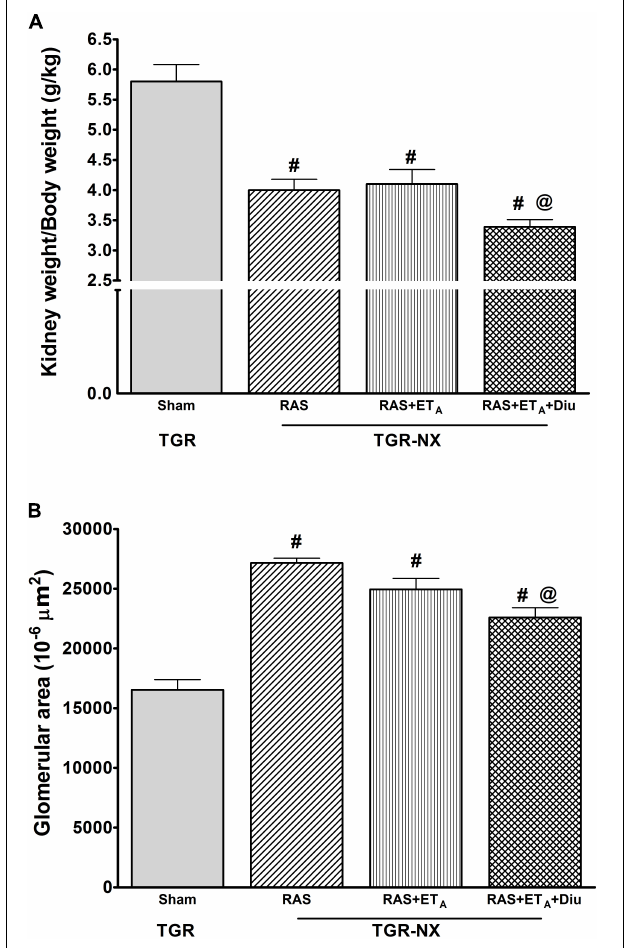
FIGURE 5 | The effect of diuretic treatment added to combined RAS and ET A blockade on histological markers of renal damage. Glomerulosclerosis index (A) and kidney tubulointerstitial injury (B) in sham-operated heterozygous Ren-2 transgenic rats (TGR-sham), nephrectomized TGR (TGR-NX) treated with the renin-angiotensin system blockade alone (RAS), combined RAS + ET A blockade (RAS + ET A ); or diuretic given with the combined RAS + ET A blockade (RAS + ET A + Diu). Diu – diuretic # P < 0.05 TGR-sham vs. other TGR-NX-treated groups, $ P < 0.05 TGR-NX + RAS treated vs. other TGR-NX-treated groups, @ P < 0.05 TGR-NX + RAS + ET A + diuretic vs. other TGR-NX-treated